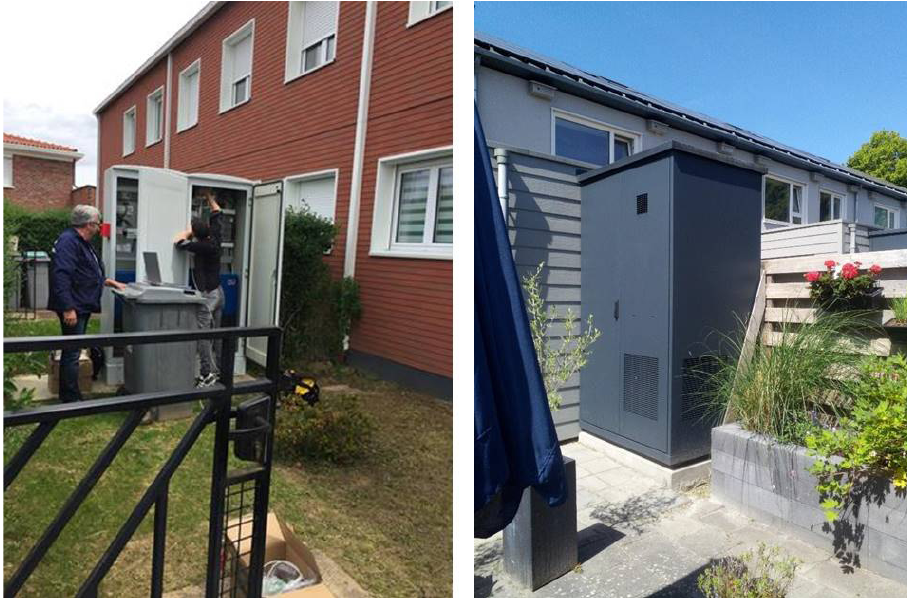
Figure 3. External plant room installed in the garden in Hem (France) and Stadskanaal